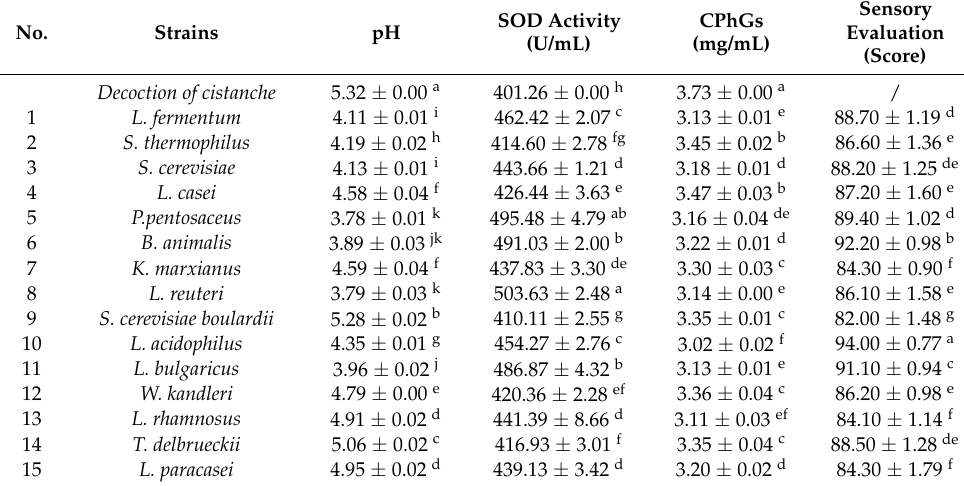
Table 3. Physicochemical properties of CFJ fermented by fifteen